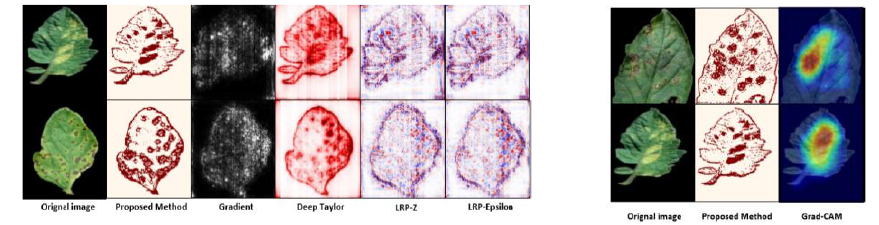
Figure 9. Comparison of Teacher/student approach visualization map with the previous approaches [67] .